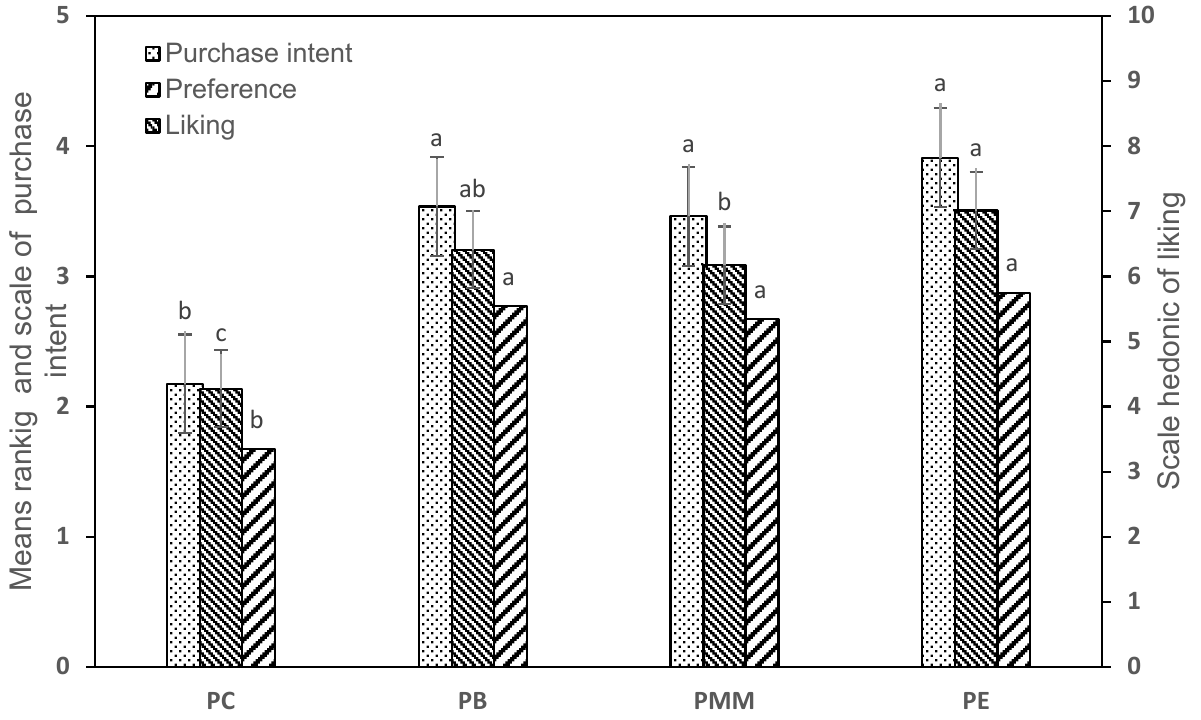
Figure 3. Acceptability, purchase intention and sample preference. a,b,c Different letters